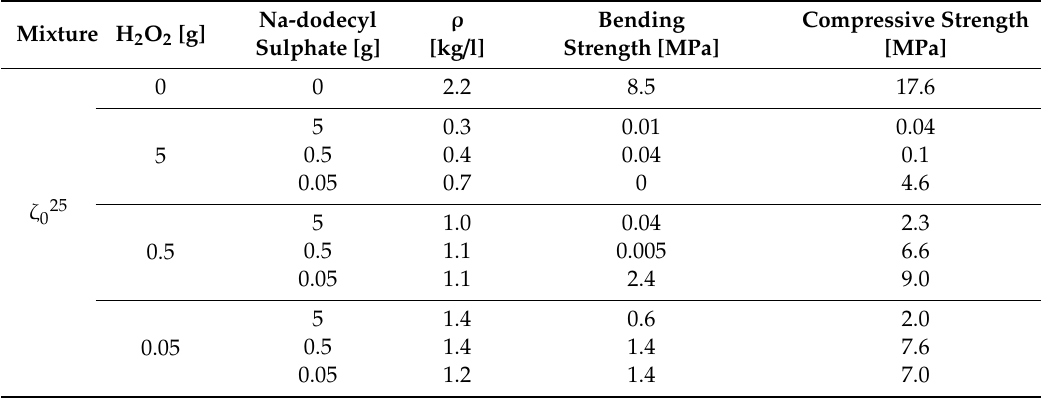
Table 15. Density, bending, and compressive strength of AAF, produced by H 2 O 2 using 25 g of mixture ζ 0 , i.e., combination of ingredients for AA resulting in literature’s highest compressive strength, cured on 70 °C for one day, measured one week after molding.